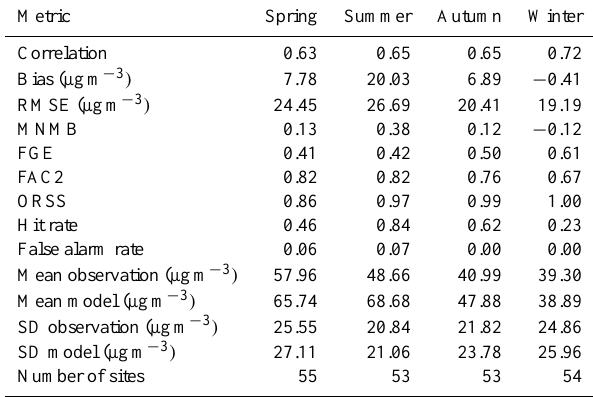
Fig. 2. Hourly variation of the mean ozone bias for the period 1 May 2010 to 30 April 2011. Table 3. Seasonal variation of model performance metrics for ozone between 1 May 2010 and 30 April 2011. The mean and standard deviation (SD) of observations and model values are also